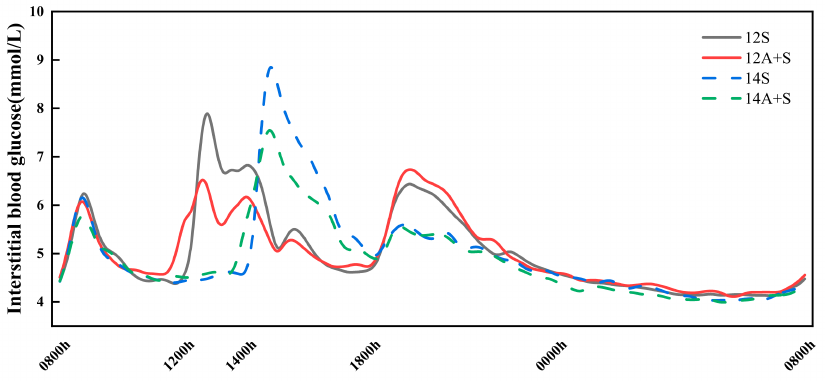
Figure 6. The interstitial glucose trace for 24 h in lunch testing trial conditions. 12S, standardized lunch at 12:00; 12A+S, apple preload 30 min prior to 12S; 14S, standardized lunch at 14:00; 14A+S, apple preload 30 min prior to